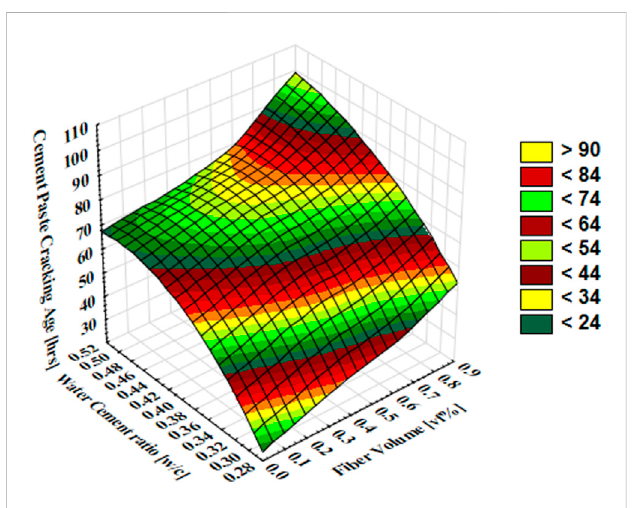
FIGURE 11 Cement-paste crack width against fi bre V f and w/c